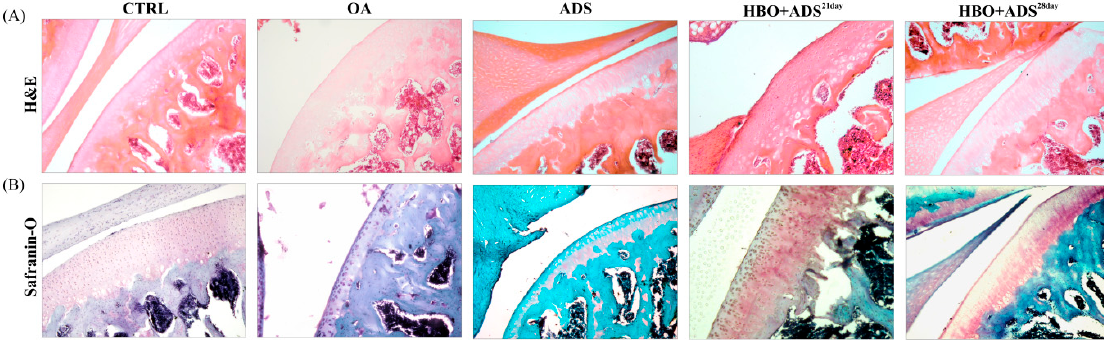
Figure 3. Representative images of knee joint sections stained with ( A ) hematoxylin/eosin (H&E) and ( B ) Safranin O-fast green (Safranin O) in CTRL, OA, ADS, HBO+ADS 21day and HBO+ADS 28day groups. Original magnification 100×.